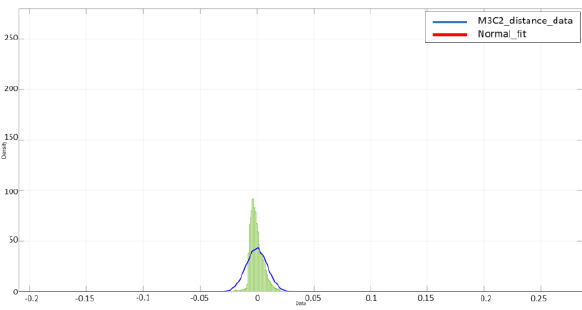
Figure 9. TLS-GoPro comparison: histograms of all the M3C2 distance values and their normal distribution